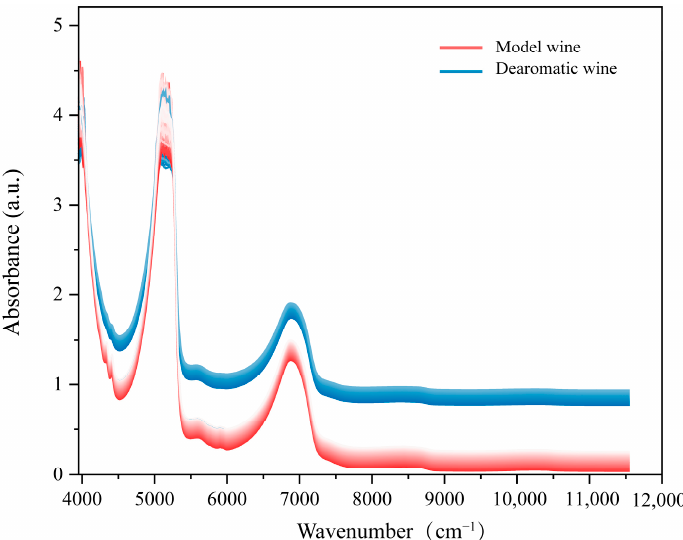
Figure 1. The raw spectra of different concentrations of Rose Oxide in simulated wine matrices and de-aromatic wine matrices.